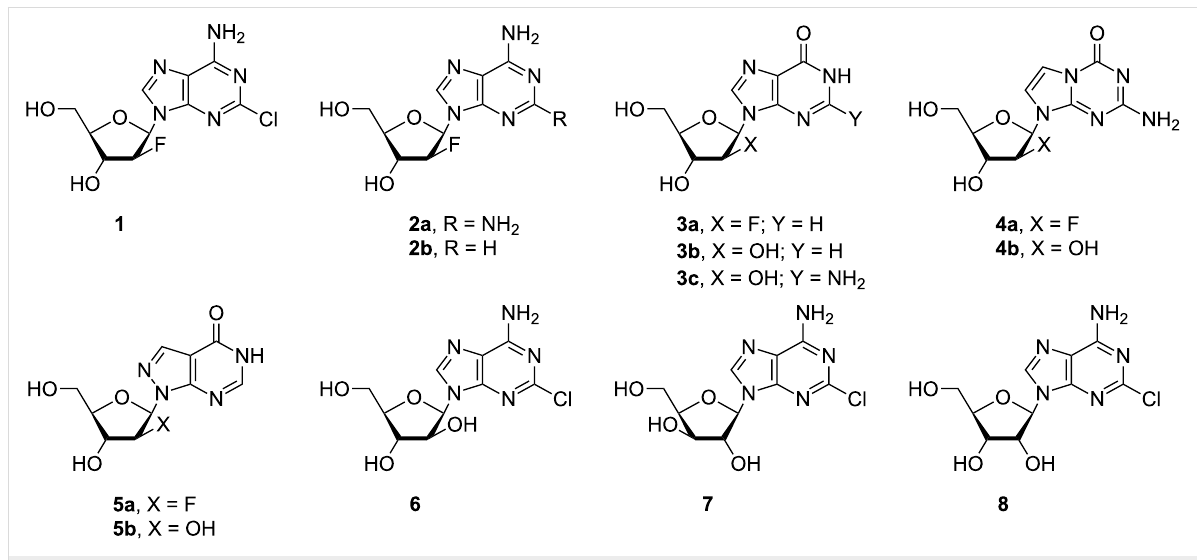
Figure 1: The structures of purine nucleosides studied in the chemoenzymatic synthesis and in a cascade one-pot transformation of D-pentoses into nucleosides of 2-chloroadenine catalyzed by the recombinant E. coli ribokinase (RK), phosphopentomutase (PPM) and purine nucleoside phosphory- lase (PNP) (purine numbering was used throughout of the